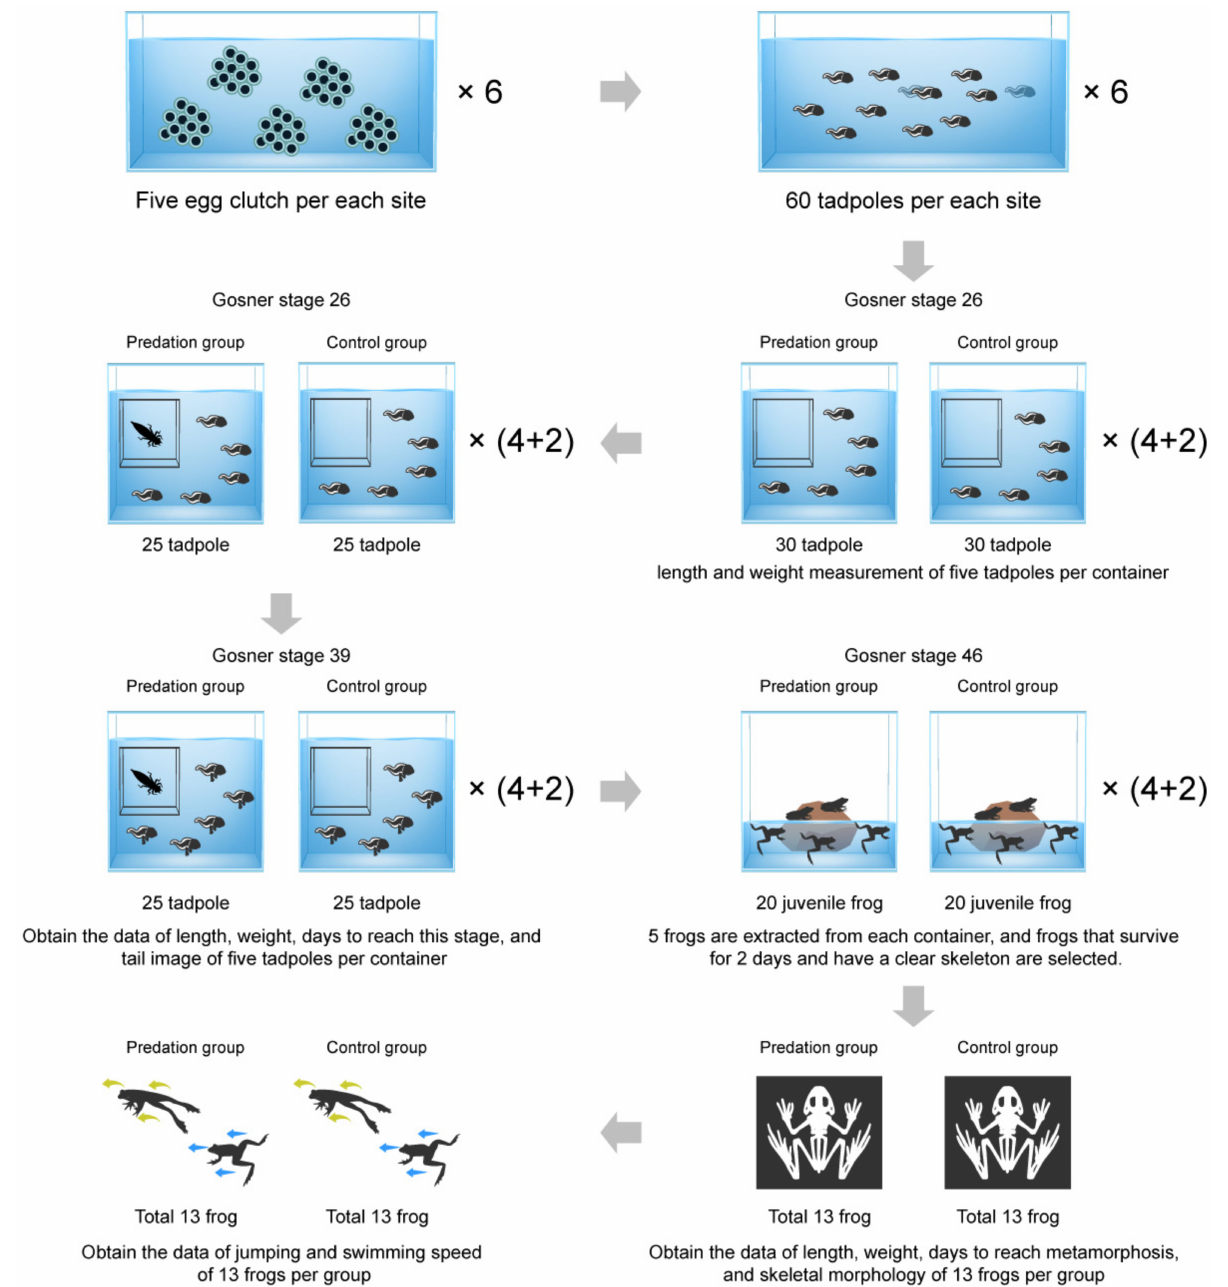
Figure 2. Flow chart for the process of this experiment. Experiments started at the Gosner stage 26 in respect to the tadpole. Individual traits were measured at Gosner stage 39 (tadpoles) and Gosner stage 46 (juvenile frogs). Of the total six experimental sets, four sets were used for experiments and two sets were kept as reserve sets, for the purposes of replenishment when tadpoles